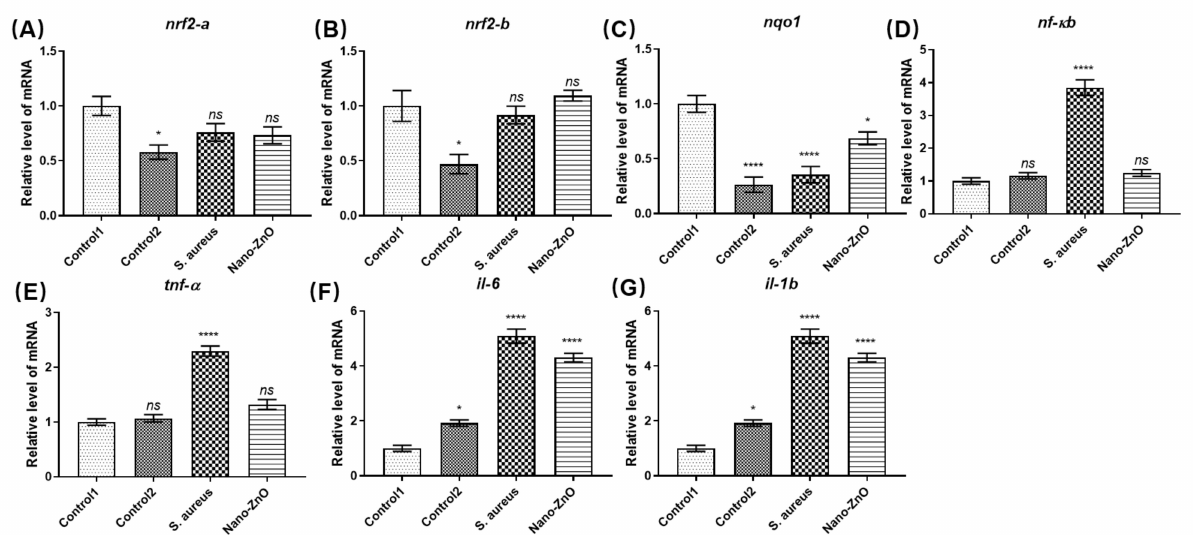
Figure 2. Effect of Nano-ZnO on the inflammatory response induced by S. aureus . Changes in mRNA levels of antioxidant signaling pathway ( A ) nrf2-a , ( B ) nrf2-b , ( C ) nqo1 , and inflammatory signaling pathway ( D ) nf-kb , ( E ) tnf-a , ( F ) il-6 , and ( G ) il-1b . (Control1: no treatment, Control2: wound + sterile water, S. aureus : wound + S. aureus , Nano-ZnO: wound + S. aureus + Nano-ZnO, n = 30, * p < 0.05, **** p <